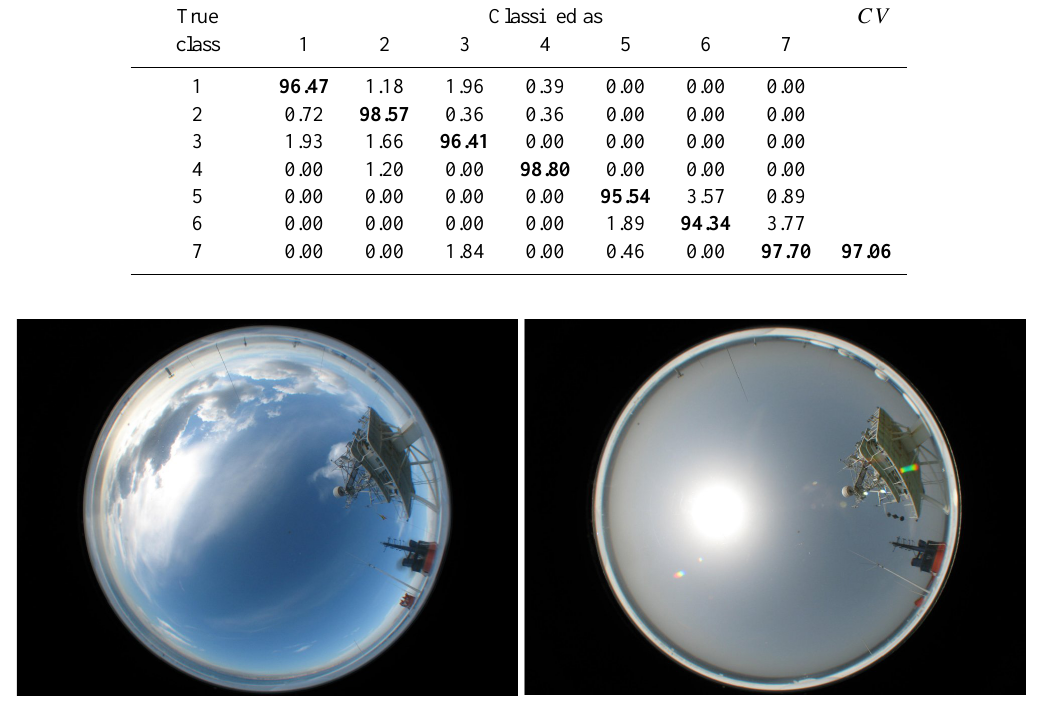
Fig. 4. Image showing cirrus and cumulus clouds (04 November 2007, 09:39 UTC) (left), image showing clear sky during a dust event (08 November 2007, 13:40 UTC) (right).